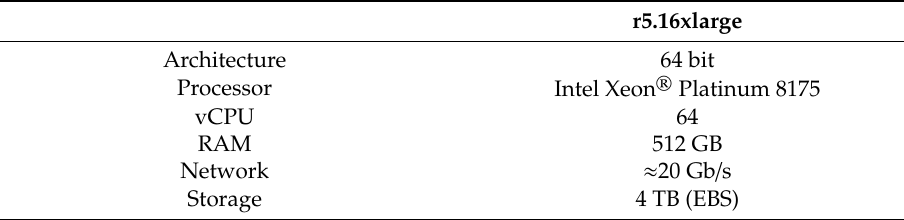
Table 2. Amazon Web Services (AWS) exploited